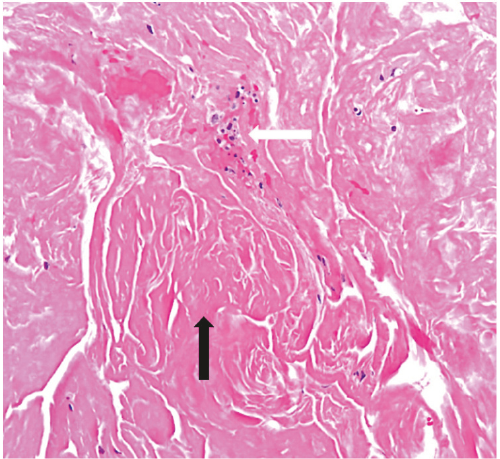
Figure 8: Postmortem finding: mucin-filled alveoli surrounded by angiomatous features of Kaposi